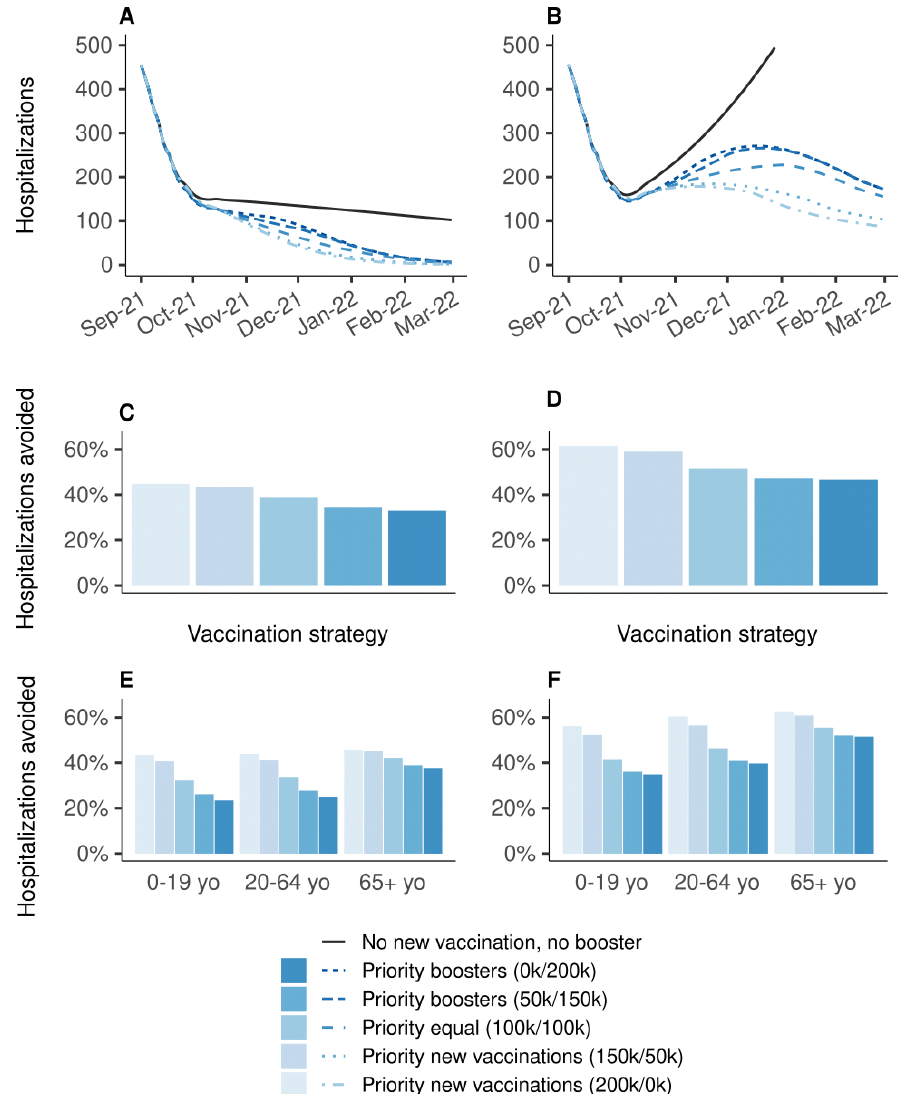
Figure 1. Effectiveness on hospitalizations of vaccination strategies varying in the allocation of 200,000 daily doses between primary vaccination and booster shots, over the period from 1 September 2021 to 1 March 2022, compared to a baseline scenario in which all vaccination is stopped on 1 September 2021. ( A , C and E ) Vaccine efficacy decreased only for people aged 65 years and older. ( B , D , F ) Vaccine efficacy decreased for all age groups. ( A , B ) Daily new hospitalizations, ( C and D ) proportion of hospitalizations avoided, ( E and F ) proportion of hospitalizations avoided by age group. A prioritization strategy of (150 k/50 k) means 150 k daily doses for primary vaccination and 50 k daily booster doses until 90% coverage of one target population is reached, then all 200 k daily doses are allocated to the other target population.